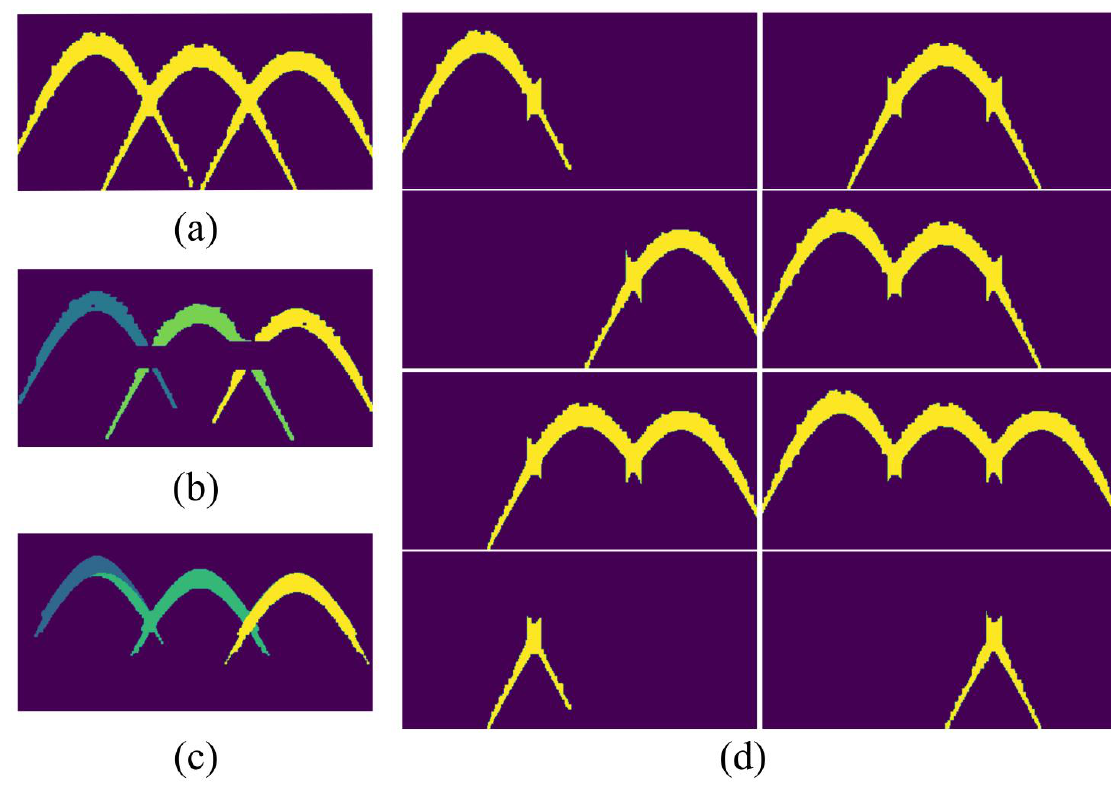
Figure 16. Interacting hyperbola segmentation comparing with C3, OSCA, and ours. ( a ) An example image with three intersecting hyperbolas. ( b ) The output of the OSCA labeling with different colors. ( c ) The output of our method labeling with different colors. ( d ) The output of C3.